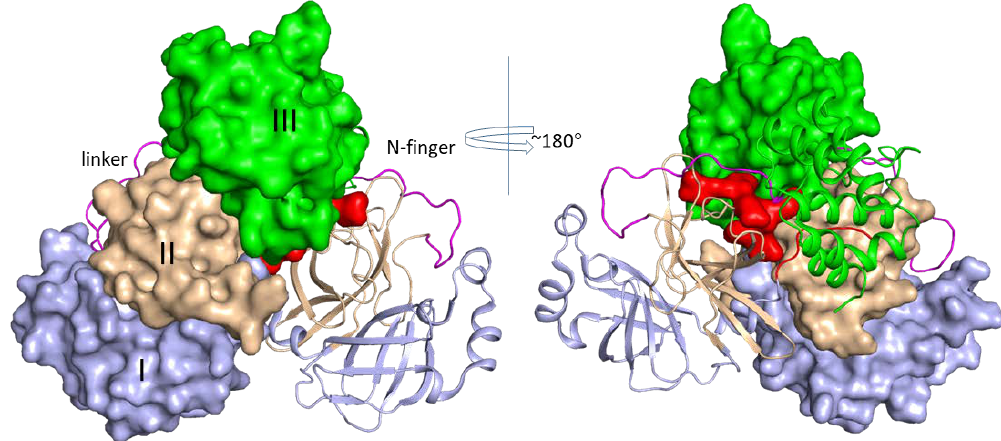
Figure 2. Structure of SARS-CoV-2 3CL pro . The N-terminal seven residues (N-finger), domains I, II, III, and the linker of domains II and III of both protomers are shown in red, light blue, wheat, green, and purple, respectively. The linker in the two protomers is shown in ribbon mode. Other domains in one protomer are shown in surface mode except the linker region, and corresponding domains in the other protomer are shown in ribbon mode. The structure (PDB ID 6Y2G) is used in this